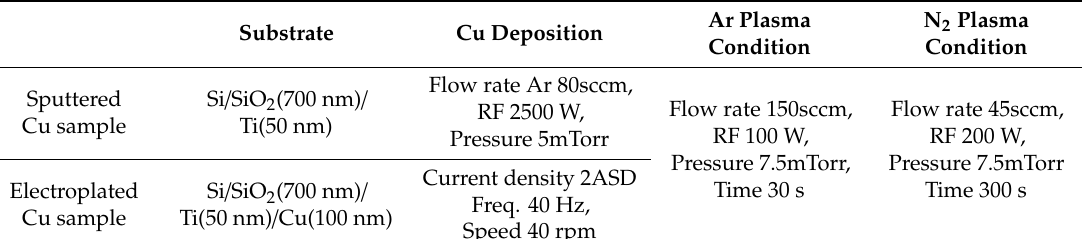
Figure 1. Fabrication process flow. Table 1. Process condition for sputtered and electroplated Cu samples.